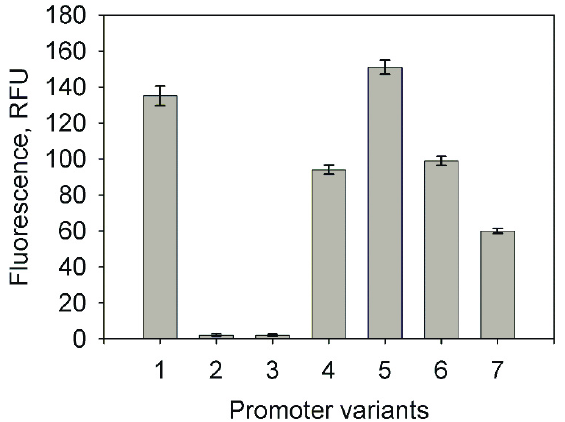
Figure 5. Effect of the promoter sequence mutations on the expression of EGFP in Rhodococcus jostii TMP1. 1—wild-type P TTMP sequence; 2—P del ; 3—P TA ; 4—P CA1 ; 5—P CA2 ; 6—P GA , 7—P AS5 . The effect of